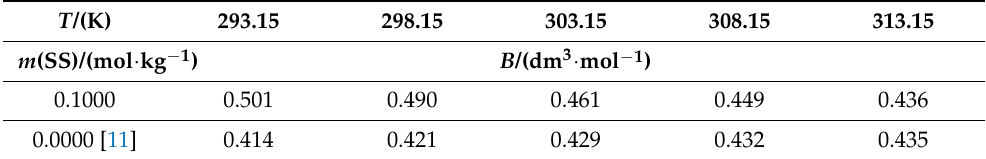
Table 6. Values of viscosity B -coefficients obtained from the Jones-Dole’s equation for caffeine in aqueous solution [12] and in 0.1 mol · kg − 1 SS aqueous solutions in the temperature range from T = 293.15 to 313.15